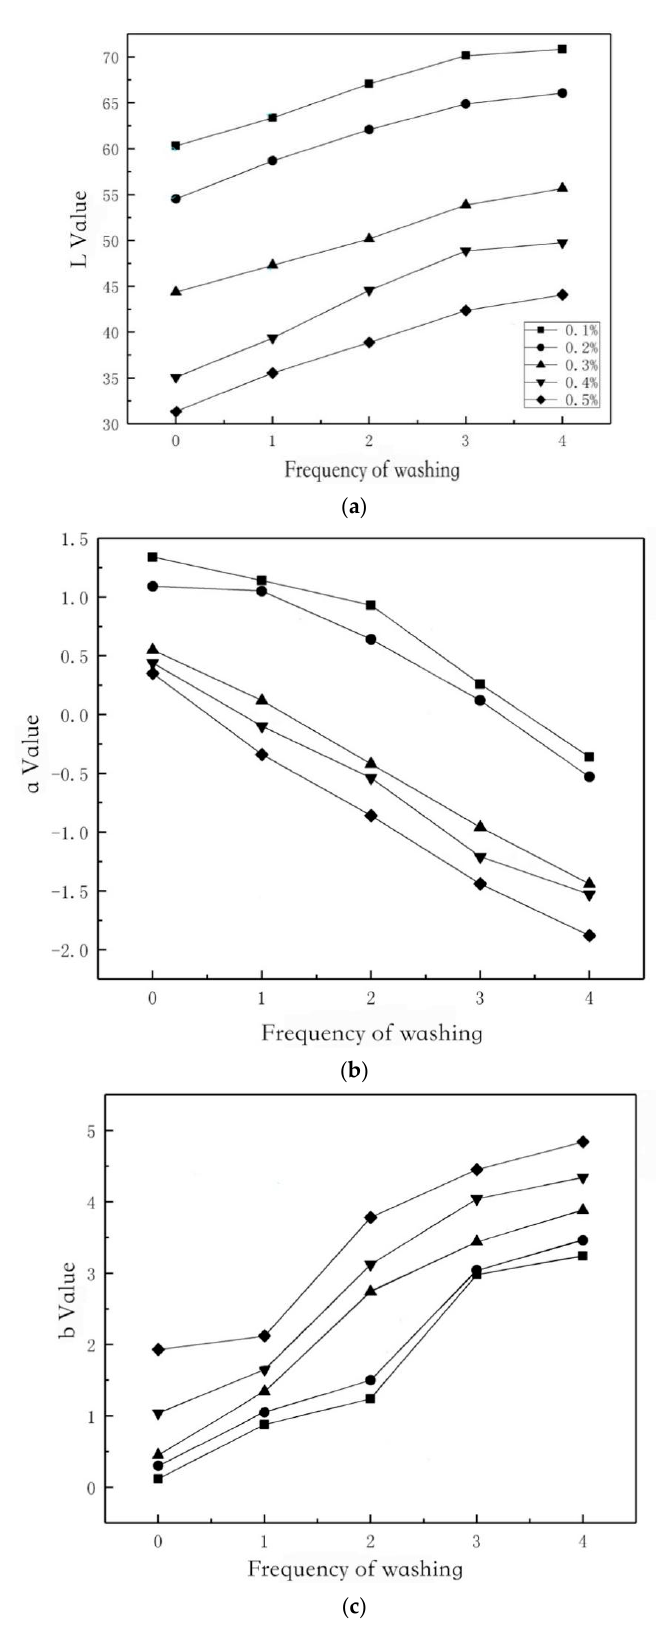
Figure 10. The relation between chromaticity indices (L*a*b) and washing number of CS / Gr modified bamboo fiber fabrics (CGBFs) with di ff erent graphene addition. ( a ) L-value; ( b ) a-value; and ( c ) b-